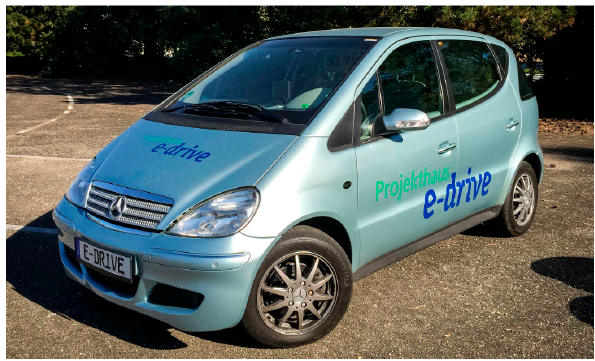
Figure C1. Vehicle under test. Figure A3. Vehicle under test. Table A2. Technical data of electric